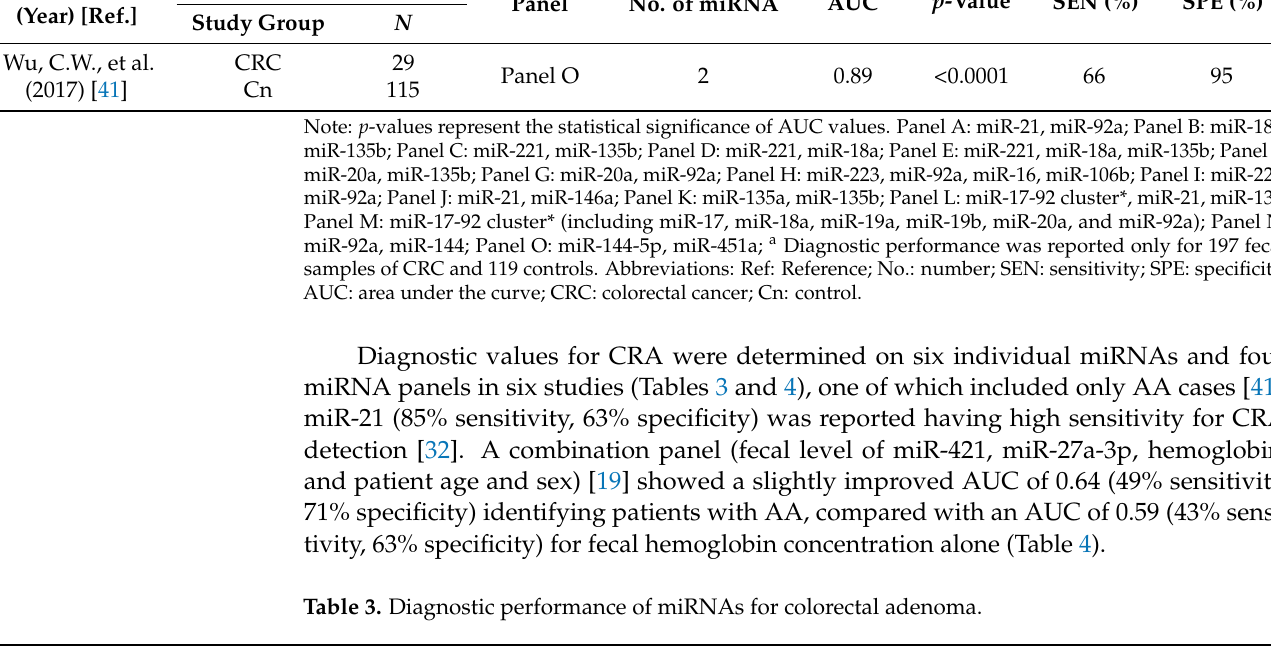
Table 3. Diagnostic performance of miRNAs for colorectal adenoma.